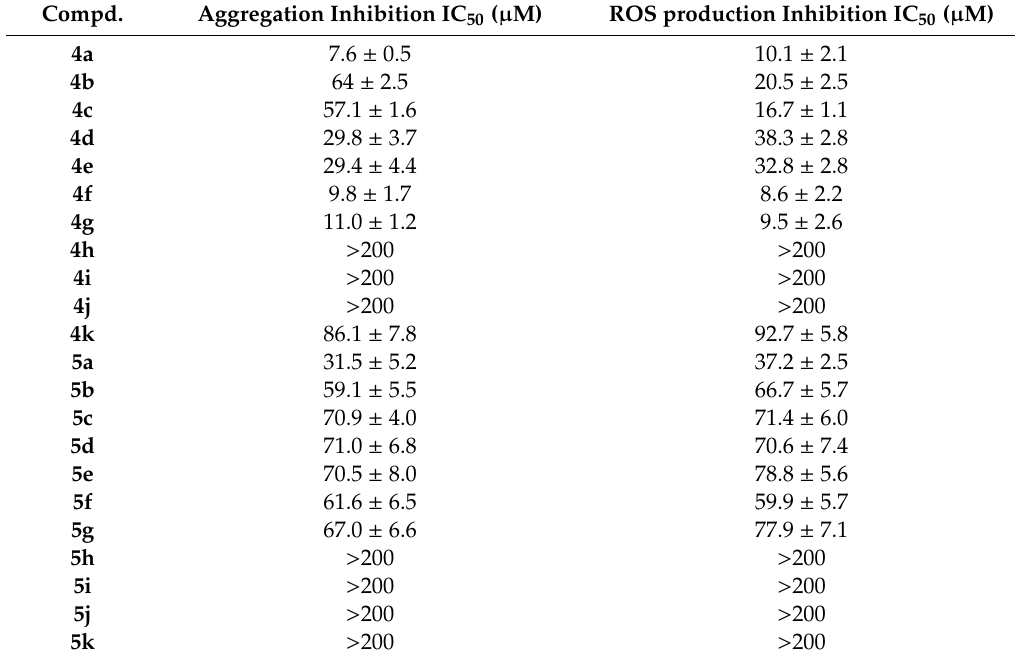
Table 2. Inhibiting e ff ect of compounds 4a – k and 5a – j on aggregation and reactive oxygen species (ROS) production expressed as IC 50 ( µ M) values. Reported data are the mean +/ - SD obtained in at least six di ff erent experiments each performed in duplicate.